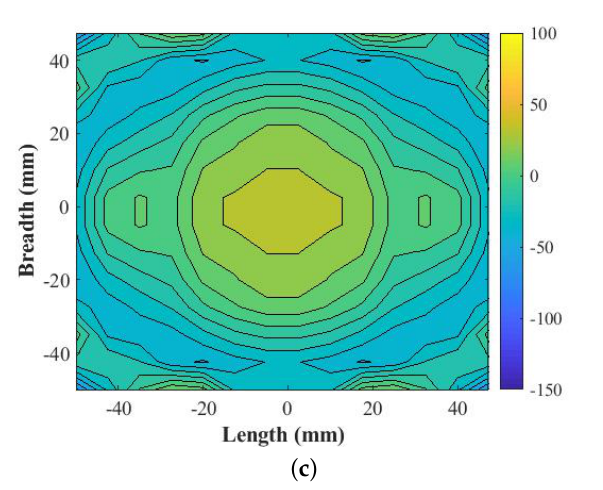
Figure 2. ( a ) Phase values above RCA in φ RP 1 (x,y) ( b ), phase values in φ RP 2 (x,y) before correction, and ( c ) modulated phase values in φ RP 2 (x,y) after correction.